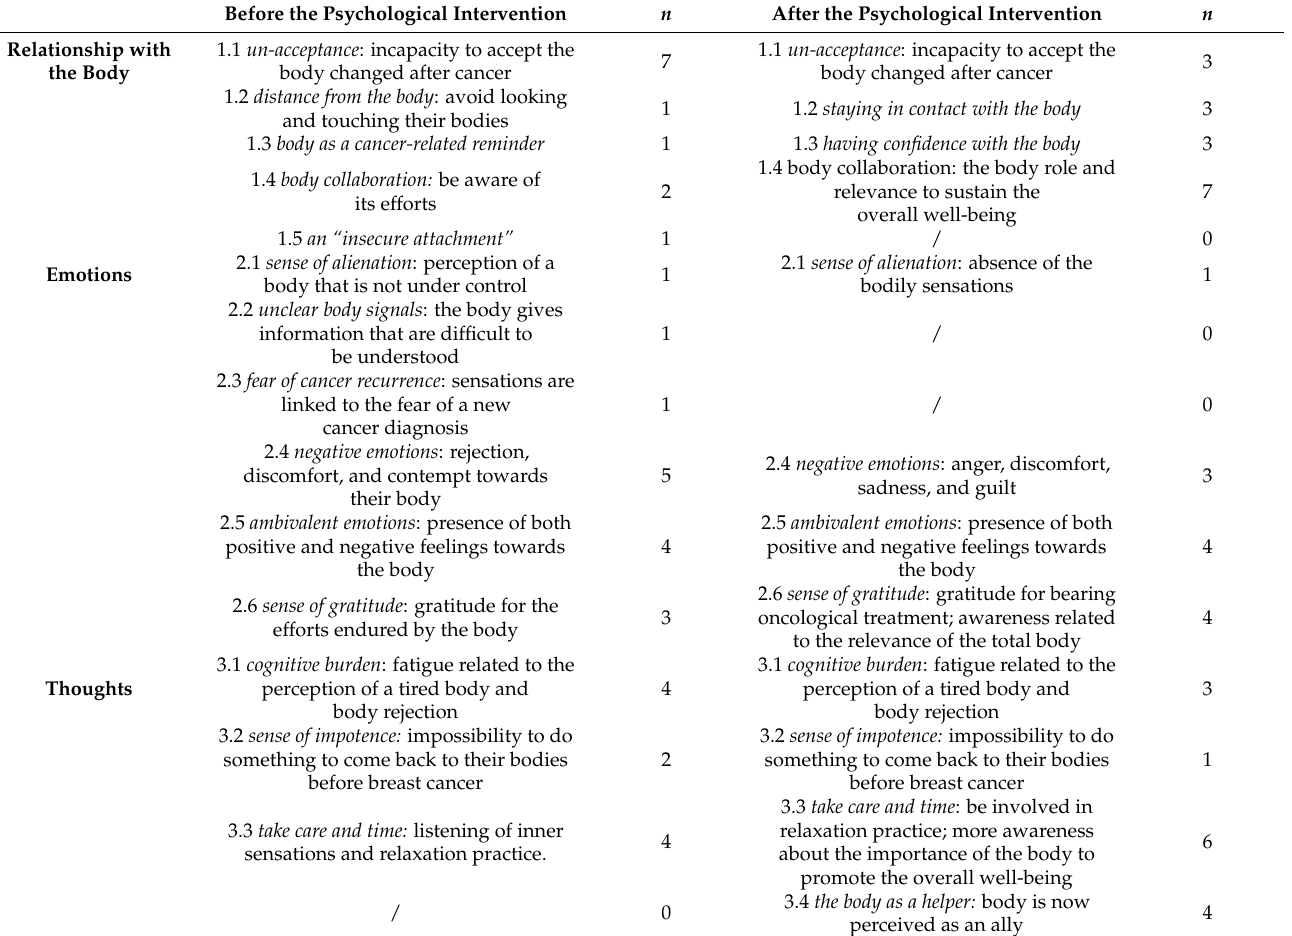
Table 3. Main themes and sub–themes emerged in the thematic